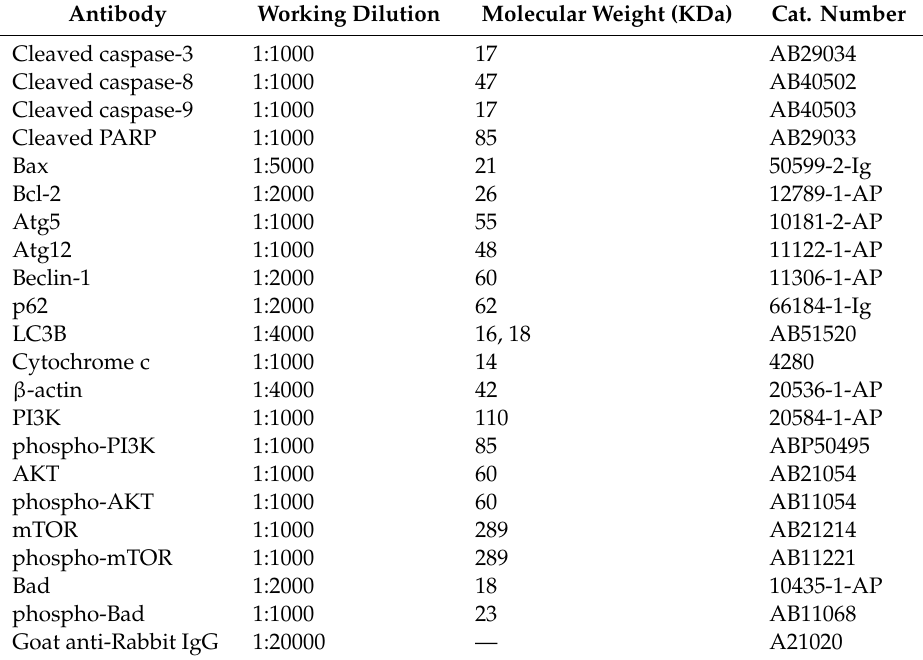
Table 1. Information on the antibodies used for Western blot analysis.